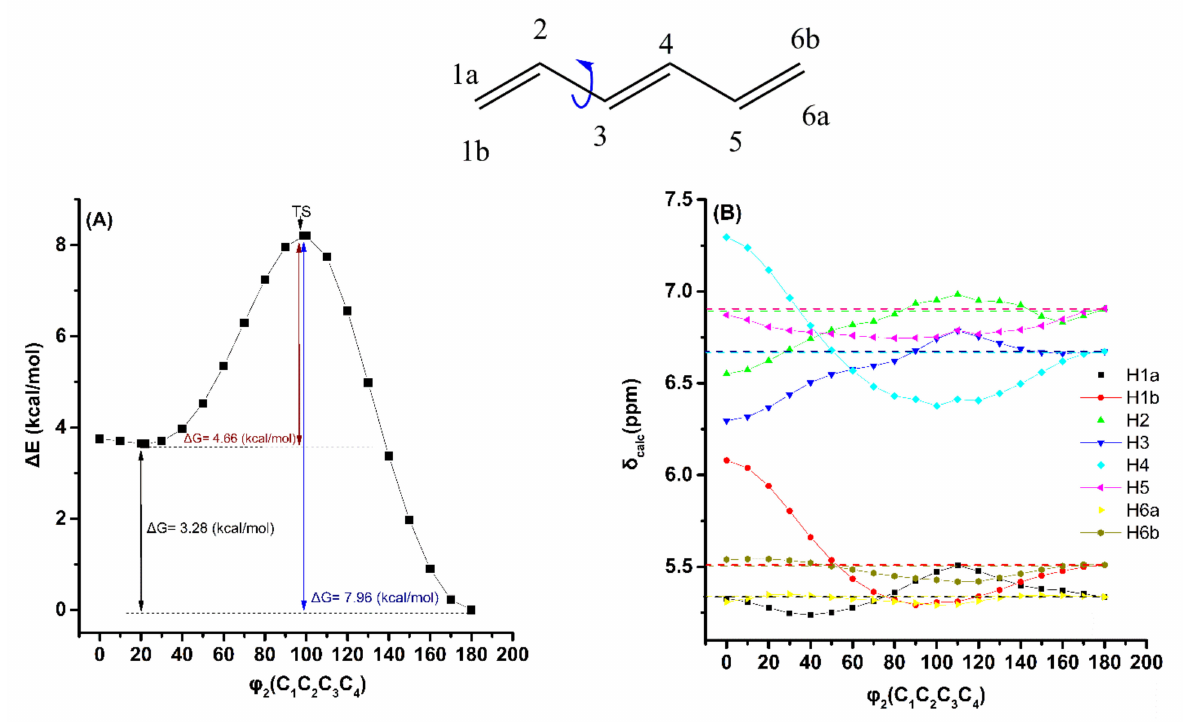
Figure 5. Effect of variation in the torsion angle ϕ 2 (C 1 C 2 C 3 C 4 ) of ( E )-1,3,5-hexatriene, with energy minimization at the B3LYP/6–31+G(d) level, on the electronic energy ∆ E (kcal/mol) (characteristic ∆ G values are also shown) ( A ) and on the olefinic δ calc ( 1 H) data (at the GIAO/B3LYP/6–311+G(2d,p) level with CPCM in CHCl 3 ) ( B ). The experimental chemical shift values are denoted with the horizontal dotted